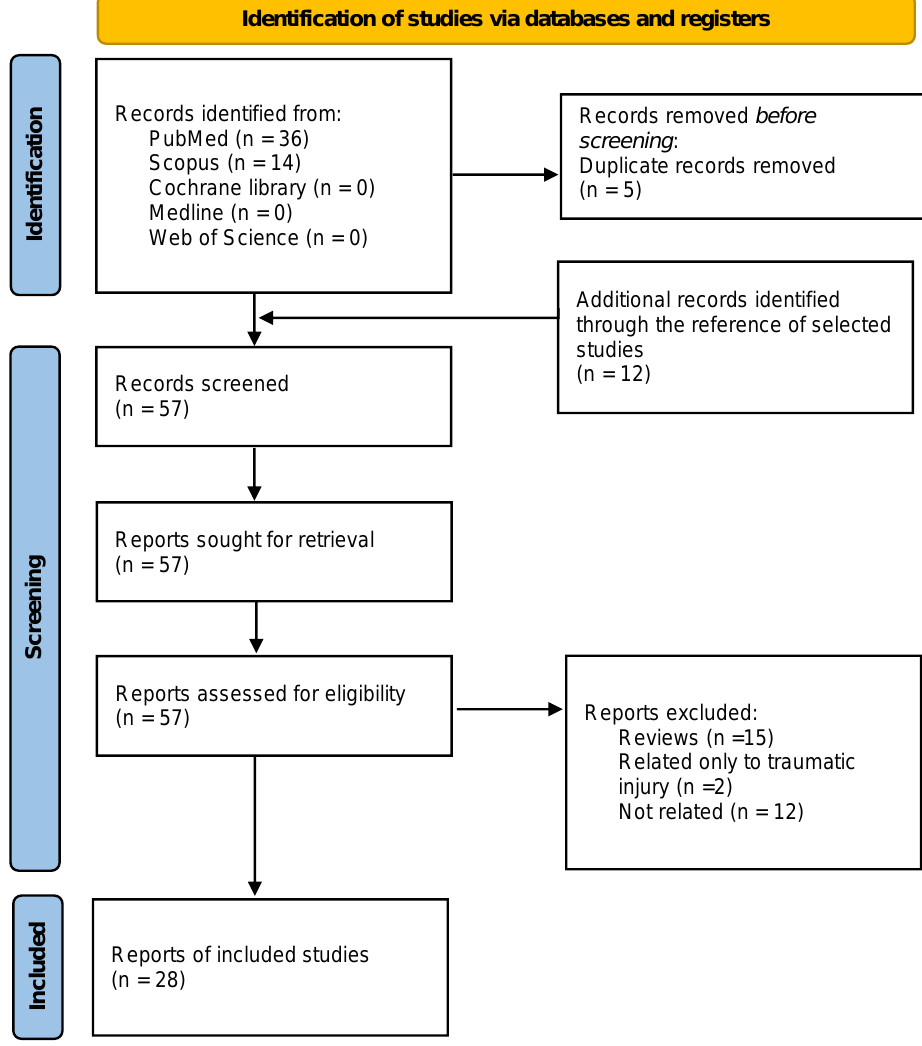
Figure 1. PRISMA workflow for the selection of articles. Table 1. Quality assessment results. Study